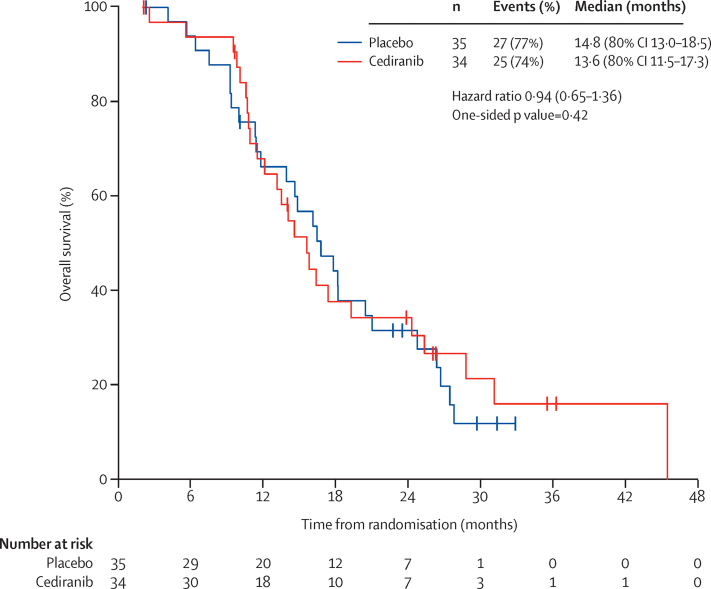
Overall survival